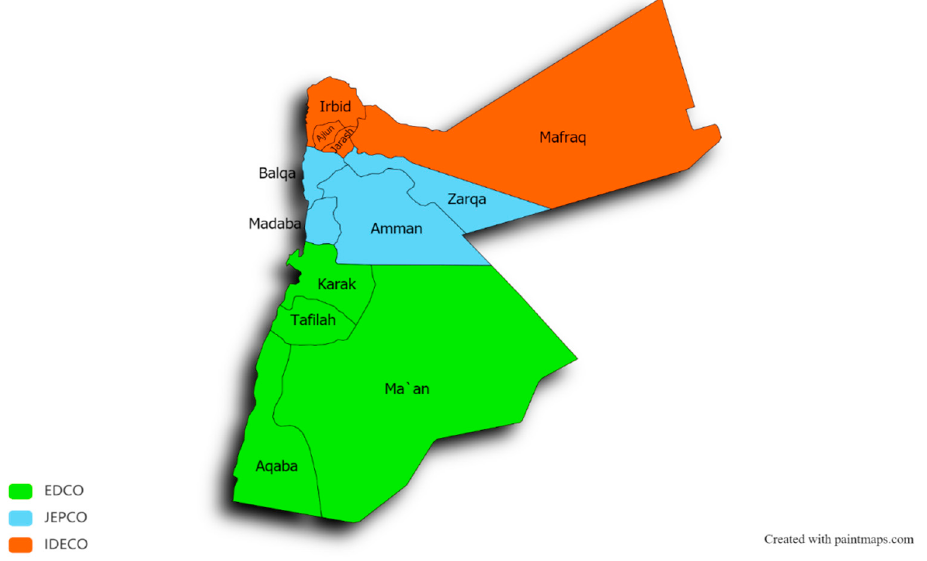
Figure 2. Electricity distribution companies in Jordan.